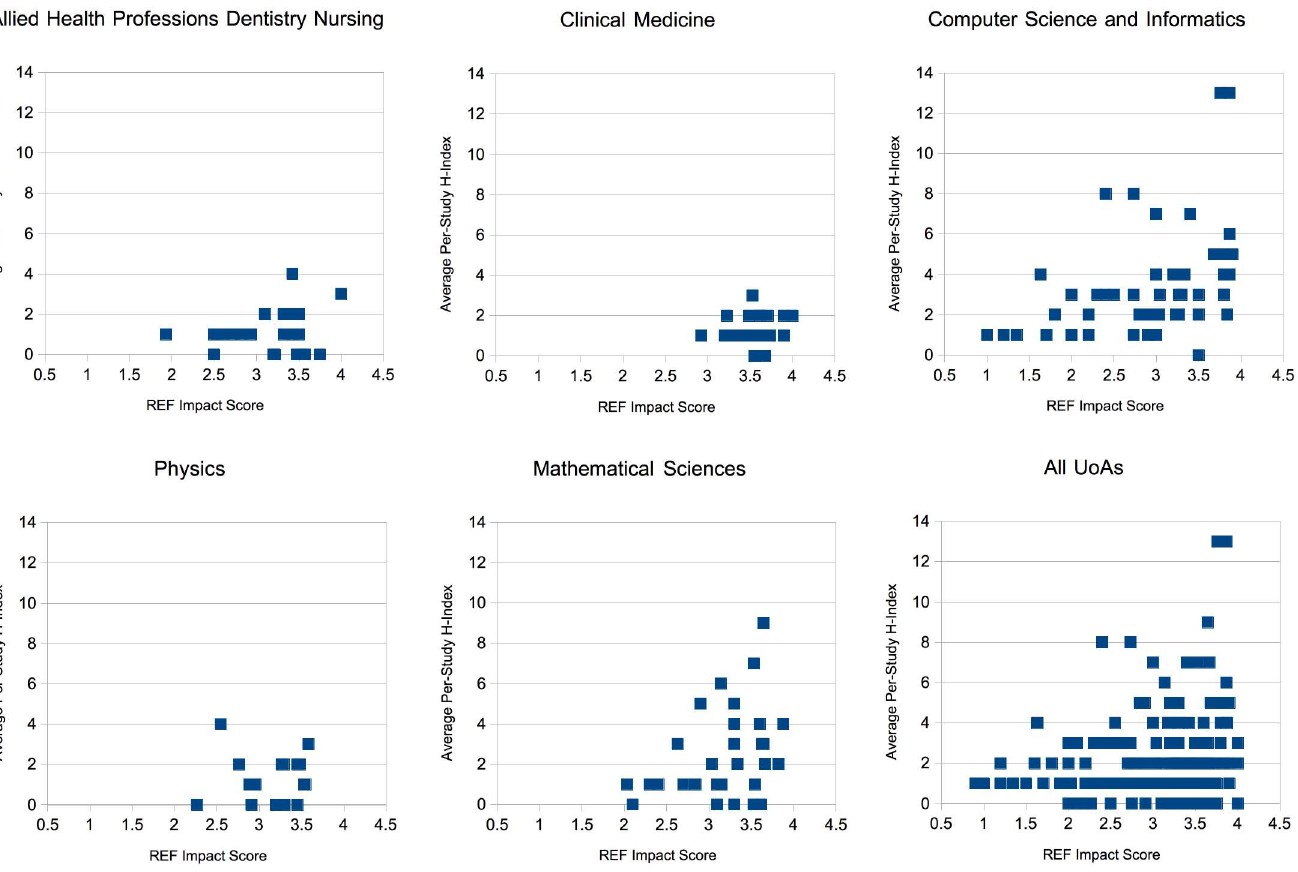
Fig 6. Averageper-study h-index vs Average REF Impact